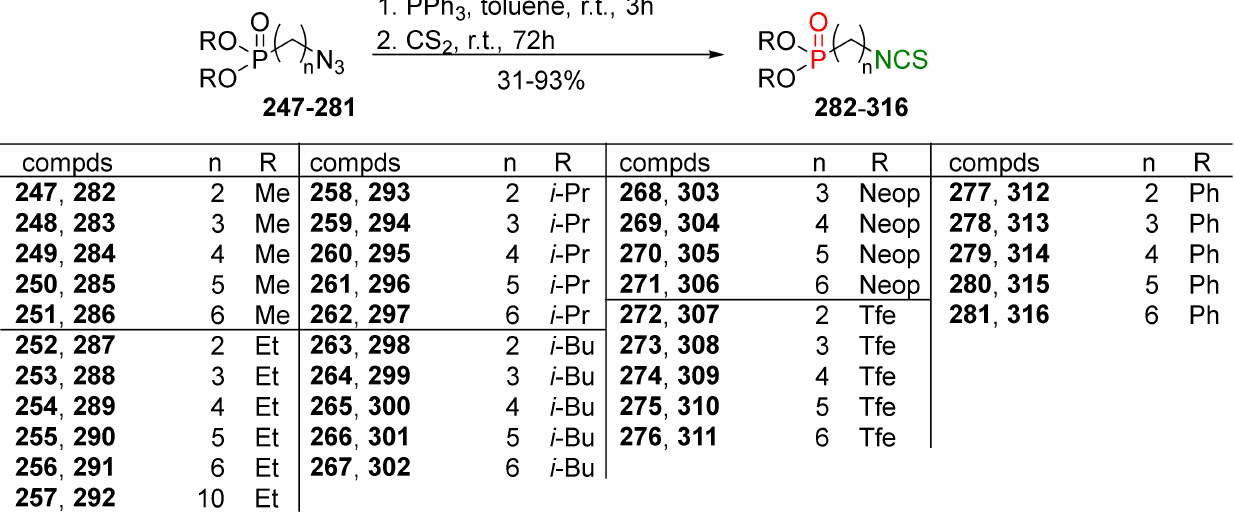
Figure 37. Synthesis of dialkyl and diphenyl ω -(isothiocyanato)alkylphosphonates 282 – 316